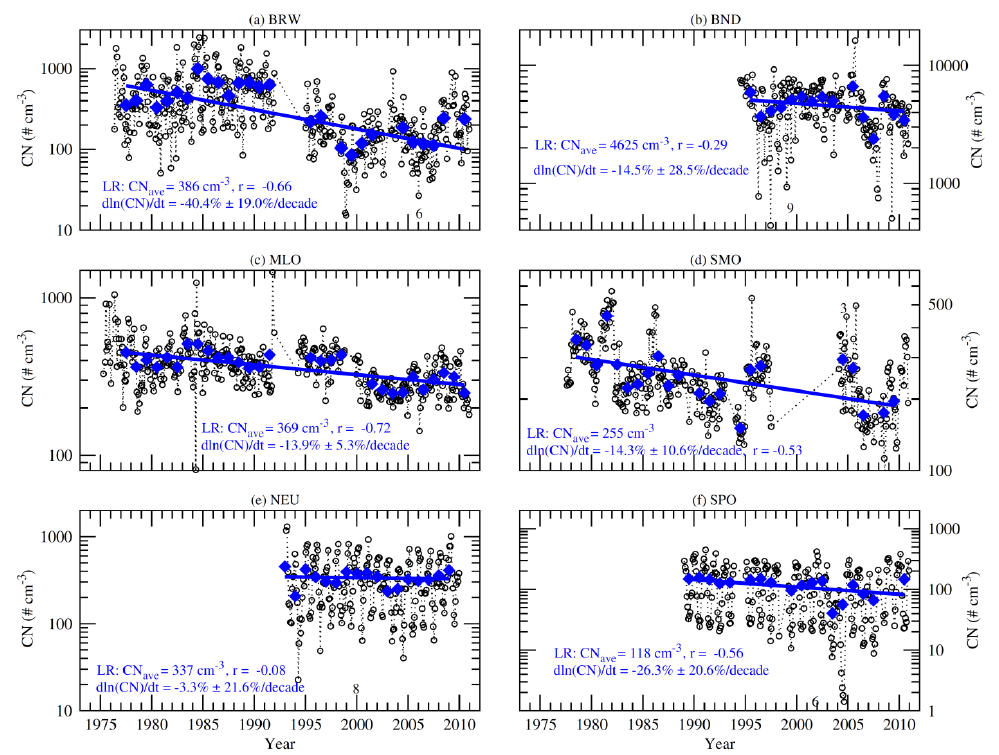
Figure 4. Fig. 4. Annual (filled diamonds) and monthly (open circles) mean CN values observed at the five NOAA sites and one German Antarctic station identified in Fig. 3c. Annual mean values are shown for years with at least 10 months of monthly mean data. In the figure, linear regressions (LR) are derived from the annual mean CN observations, and the corresponding mean CN values, Pearson’s product moment correlation coefficients ( r ), and slopes (with 95% confidence intervals for the regression slopes) are given in the